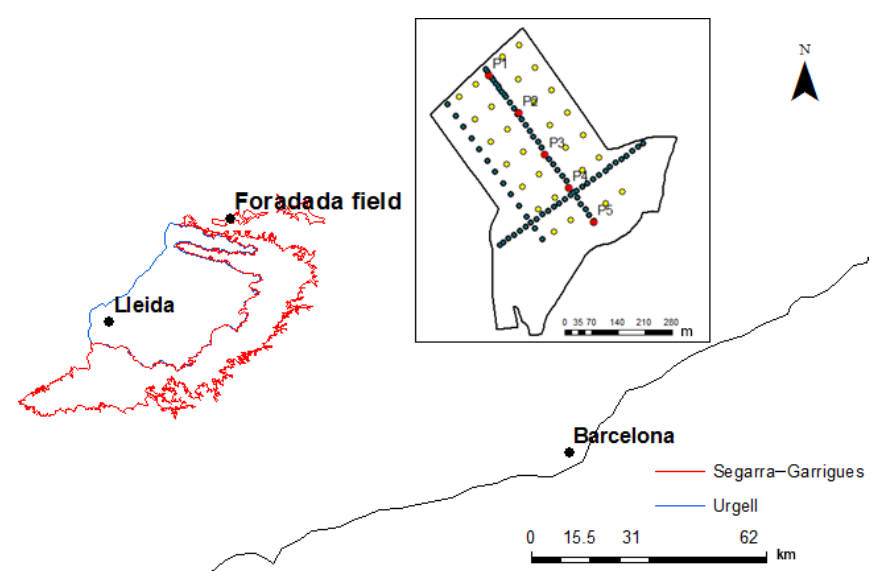
Figure 1. Location of the Foradada field site within the Segarra-Garriga irrigation system and distribution of soil moisture measurement points. Gravimetric measurement points are arranged with cross section points in green and support points in yellow. The location of EC-5 sensors are represented in